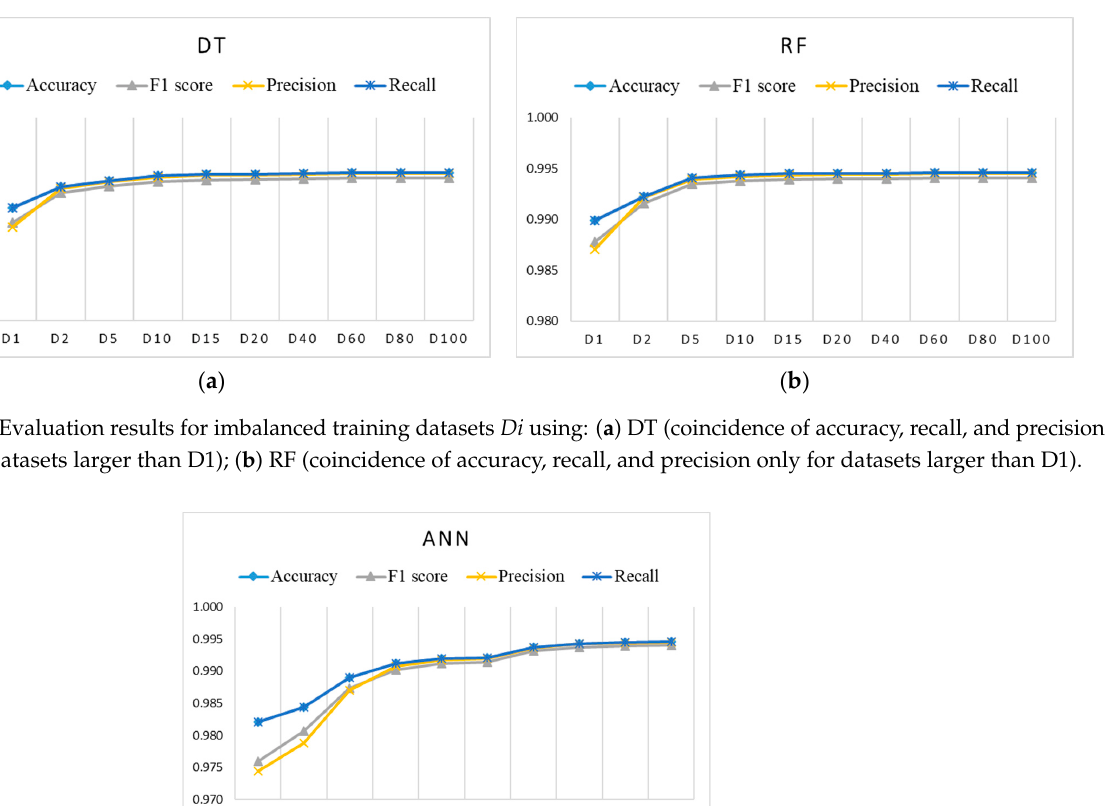
( b ) Figure 9. Accuracy measure on imbalanced training datasets Di : ( a ) training accuracy (coincidence of RF and DT); ( b ) test accuracy (coincidence of RF and DT). 3.2.2. Confusion Matrix (D20) Figure 10 presents classification results for training dataset D20 to be used as orien- tation points in the identification of the best ML algorithm on balanced datasets. LR and ANN provide good classification of the largest class ‘NL’, but misclassify many anoma- lies. DT and RF provide good classification for all other classes, except for class DoS with 375 misclassified samples. Only SVM algorithm correctly classifies all anomalous samples, but it performs the worst at classifying the normal class ‘NL’. ( a )